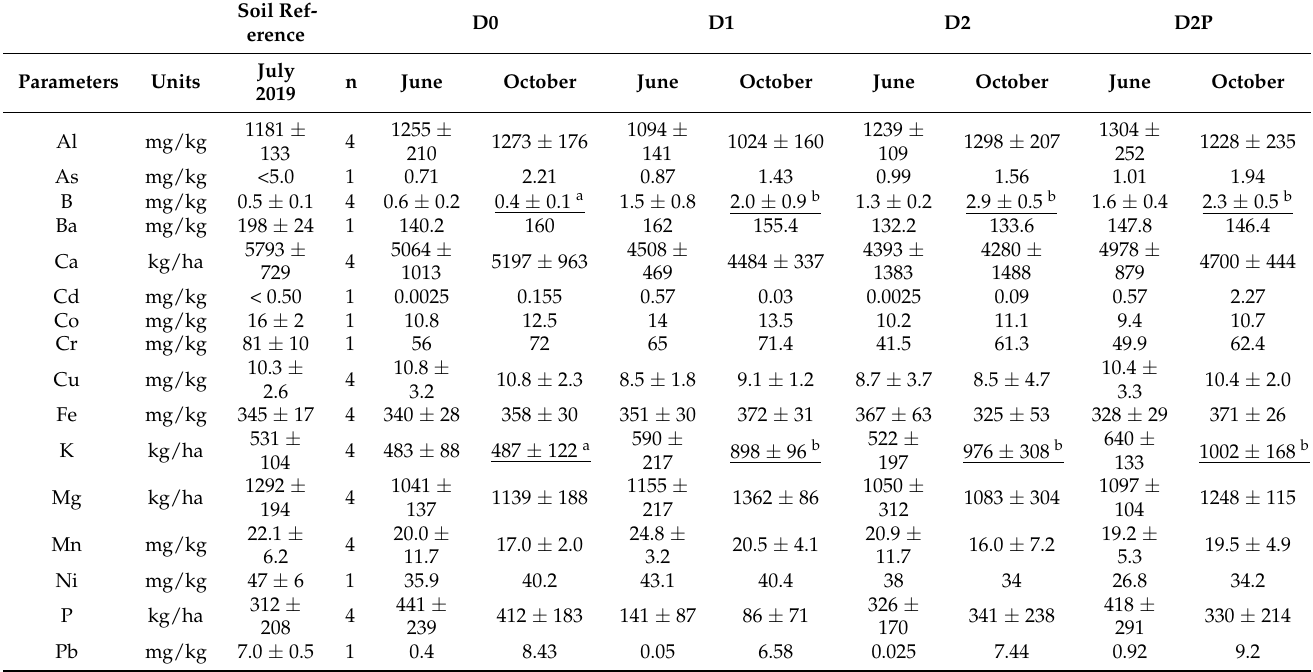
Table 1. Variation in the seasonal concentration of trace elements and macronutrients in the soil before (June) and after (October) irrigation with groundwater (D0) and leachate (D1, D2, and D2P) in 2020. Soil Ref- D0 D1 D2 D2P erence